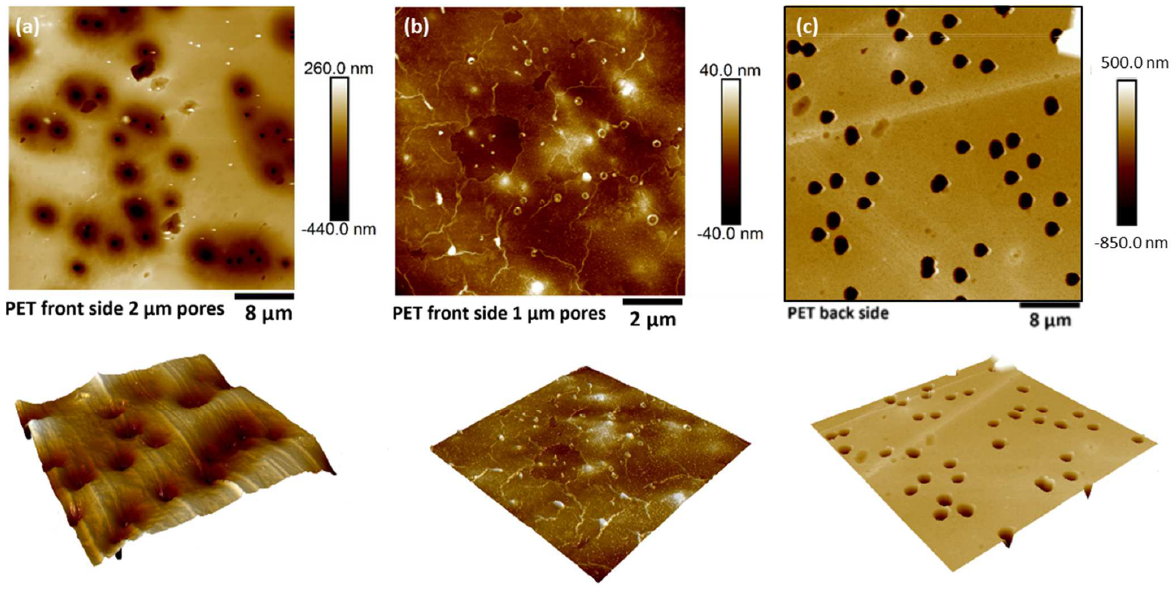
Figure 6. Representative topographies of CNM-composite membranes with PET supports of variable porosity. Topography of the front side showing suspended CNMs for pore sizes of ( a ) 2 µ m and ( b ) 1 µ m. ( c ) Topography of the back side (neat PET) used for pore diameter calculation. Additionally included are respective 3D AFM topographies. Table 1. Processing parameters of the three types of porous PET substrates etched for duration of 0 min (not etched), 8 min, and 10 min, together with sample coding: (i) thickness of 36 µm with high pore density (HD), (ii) thickness of 23 µm with high pore density (HD), and (iii) thickness of 23 µm with low pore density (LD).